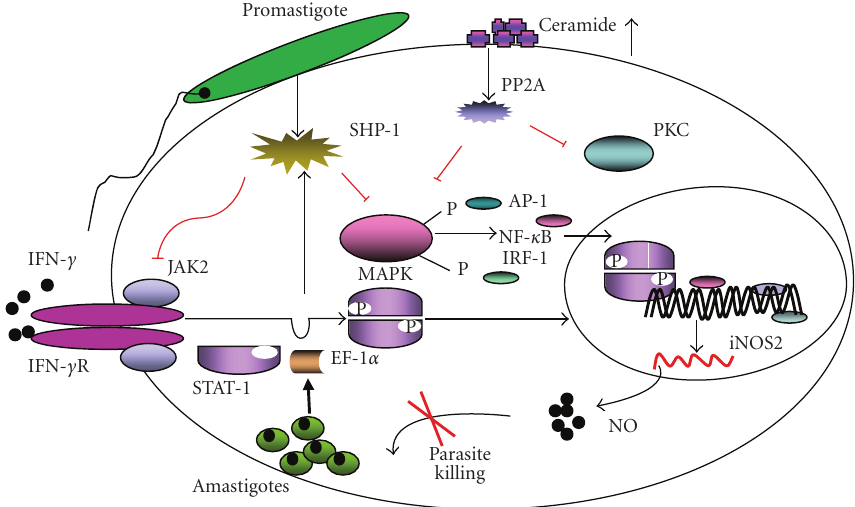
Figure 5: MAPK phosphorylation in Leishmania -infected macrophages: Leishmania infection of macrophages represses the most important MAPK family members: ERK1/2, p38, and JNK. MAPK inactivation is accompanied by inhibition of transcription factors Elk-1, c-fos, IRF-1, AP-1, and NF- κ B and IFN- γ -dependent NO